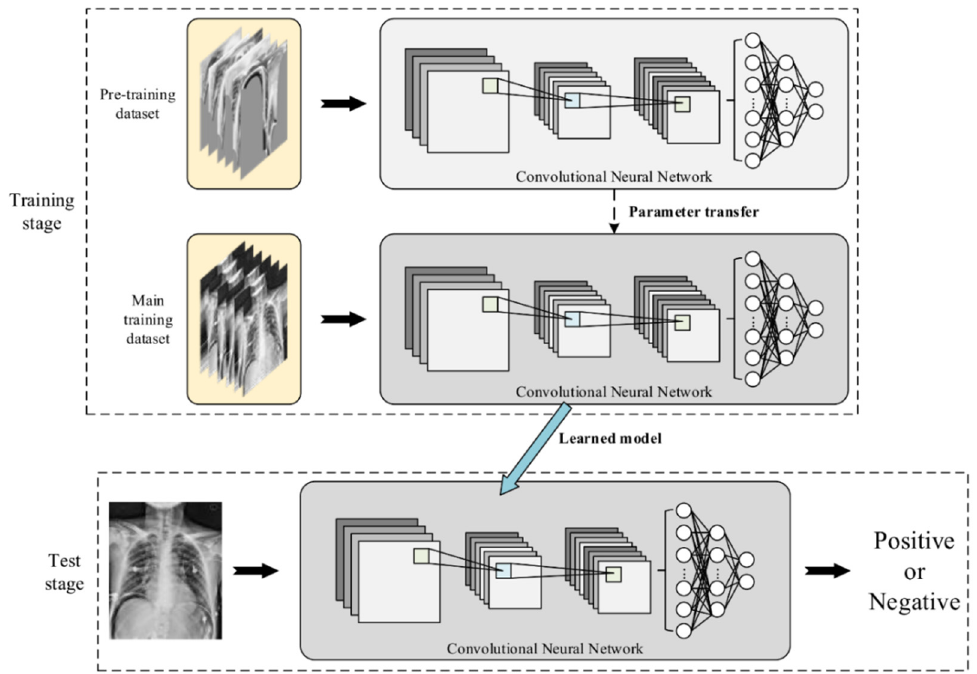
Figure 4. The training and test procedures of the proposed pneumoperitoneum classifier.